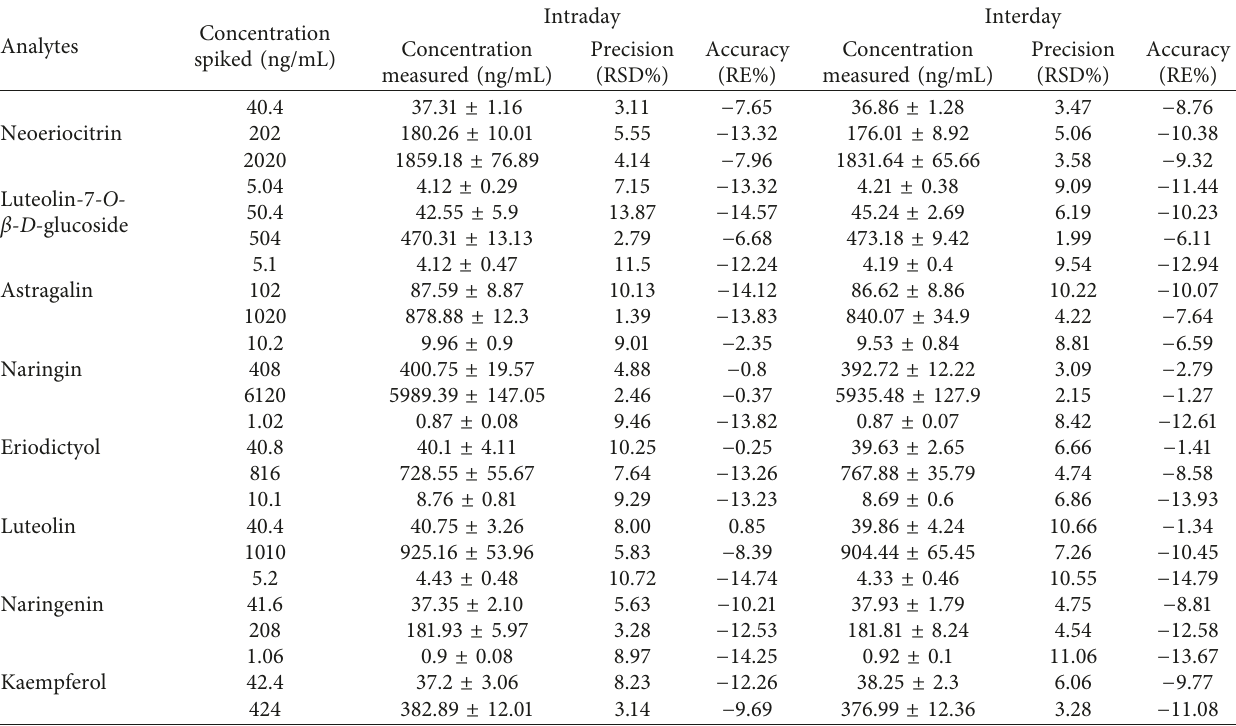
Table 3: Precision and accuracy for the determination of eight analytes ( n �